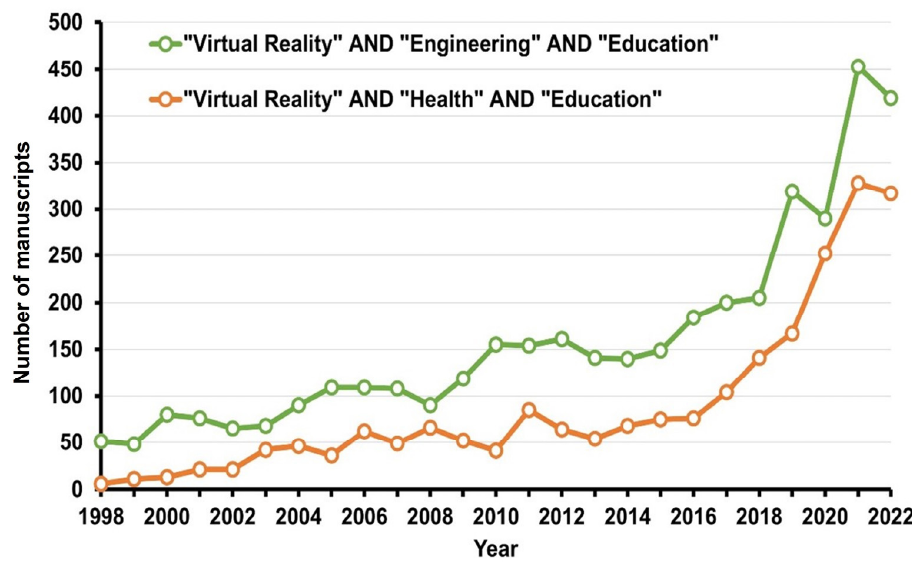
Figure 2. Number of research papers indexed in SCOPUS (data collected in February 2023).